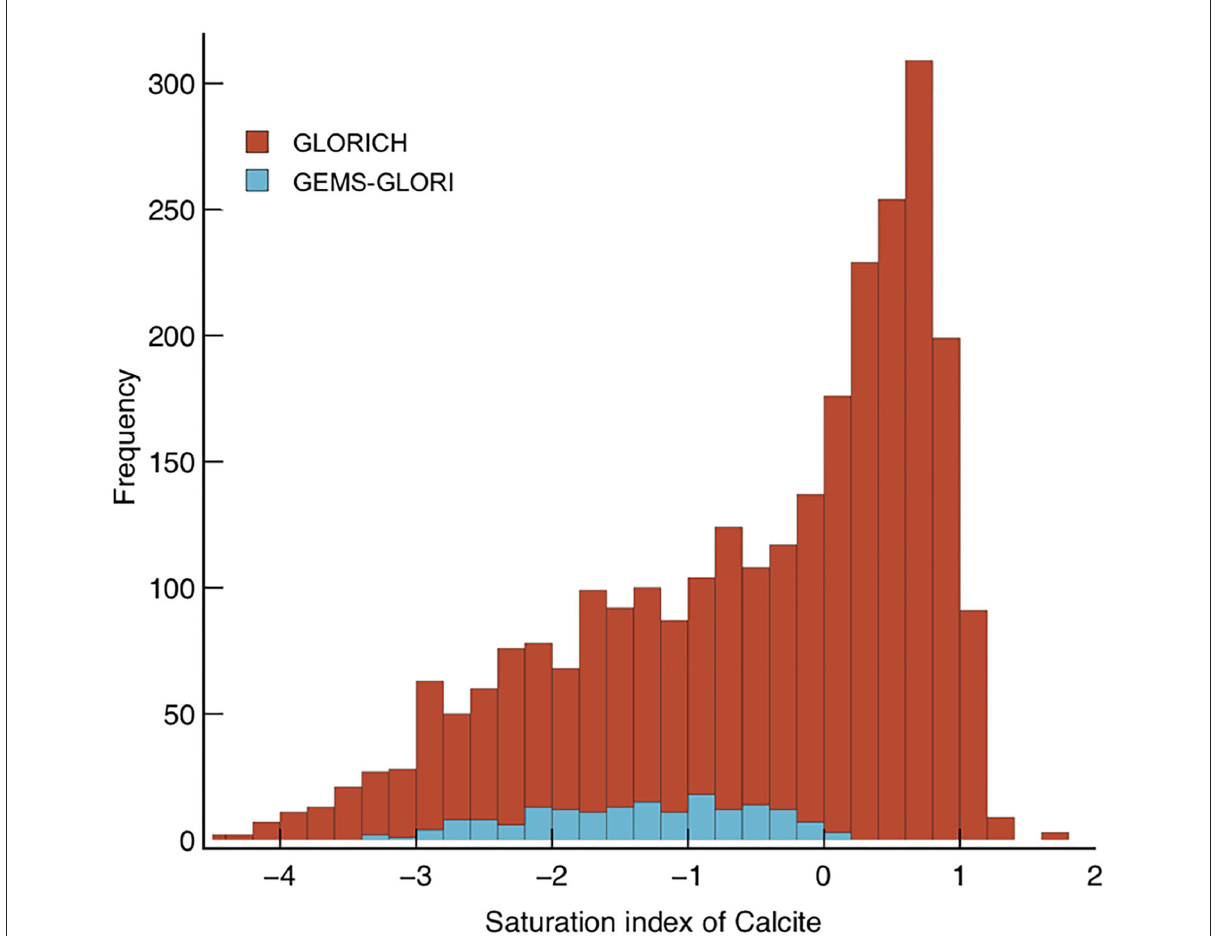
FIGURE4 Stacked histogram displaying calculated SIc values for rivers in the GEMS-GLORI (Meybeck and Ragu, 2012) and GLORICH (Hartmann et al., 2014) databases. Mean discharge for GLORICH data is 5 km 3 yr − 1 , the mean for GEMS-GLORI is 170 km 3 yr − 1